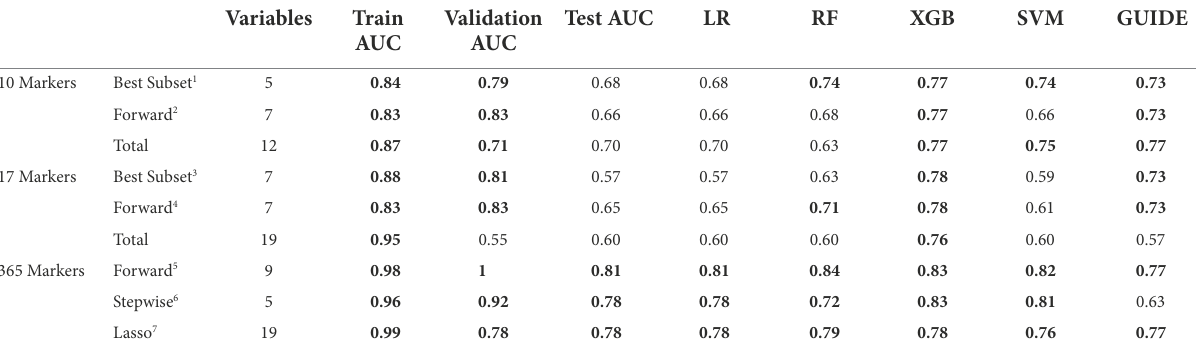
TABLE 2 Performances of different multiple marker selection methods and test AUC comparison in prediction